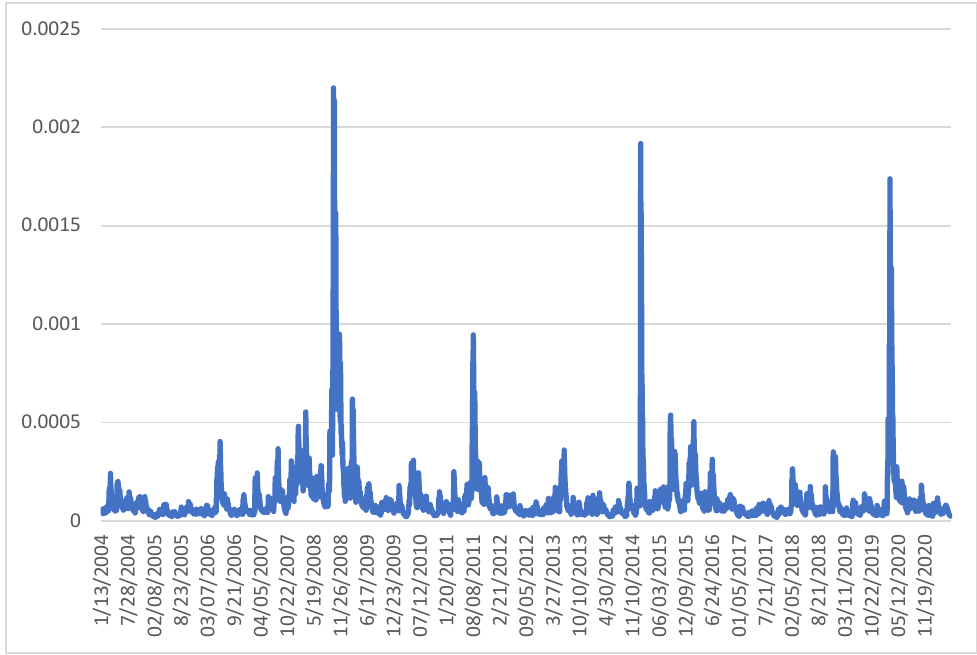
Figure 1. The conditional variance of the Swiss market index